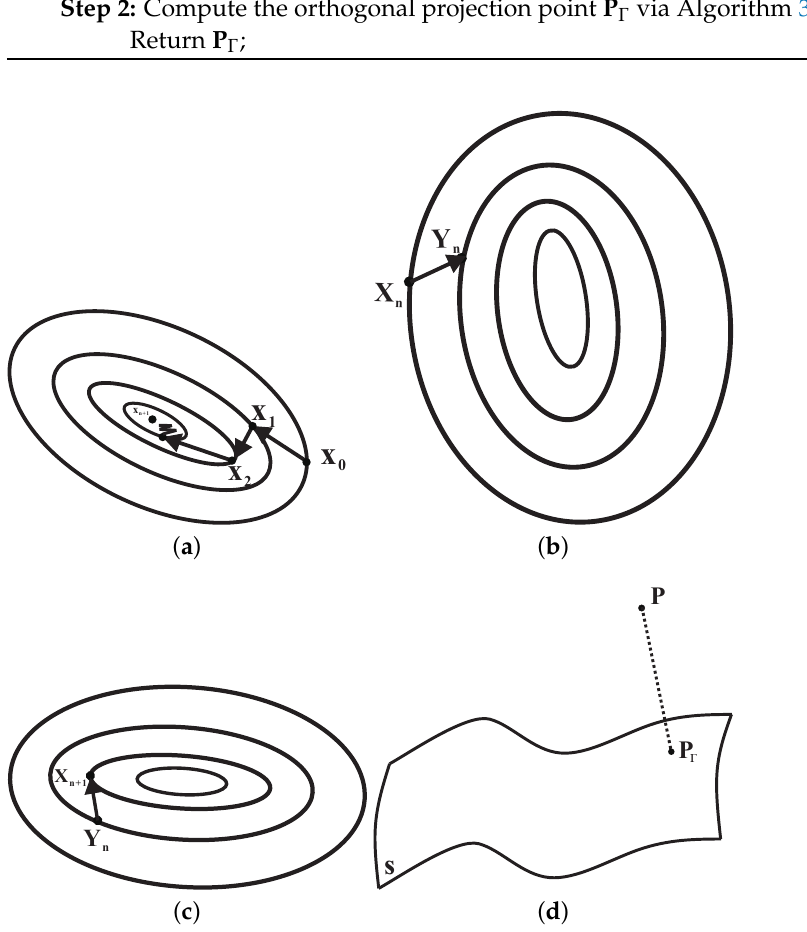
Figure 6. The complete graphic demonstration of Algorithm 5. ( a ) Algorithm 1 related to Newton’s gradient descent method; ( b ) Newton’s gradient descent method unrelated to test point of the first formula in Equation (15); ( c ) Newton’s gradient descent method associated with test point of the second formula in Equation (15); ( d ) Point orthogonal projection onto algebraic surface. All the curves of figures ( a – c ) are contour surfaces and not contour